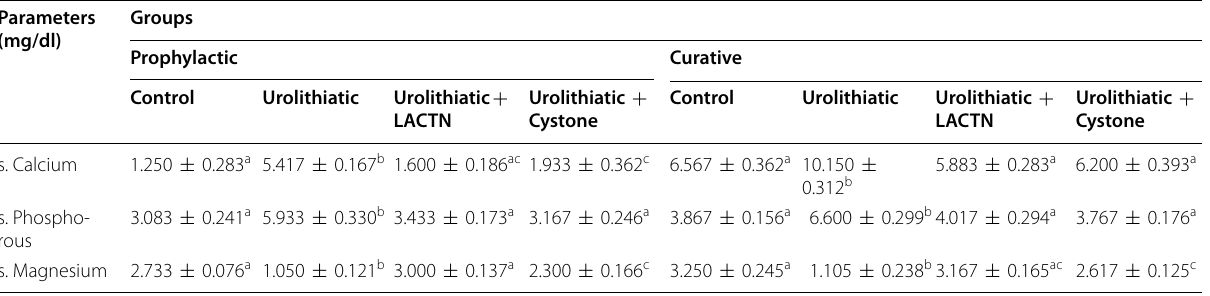
Table 7 Effect of polyherbal formula (LACTN) on some serum elements of urolithiatic rats Parameters